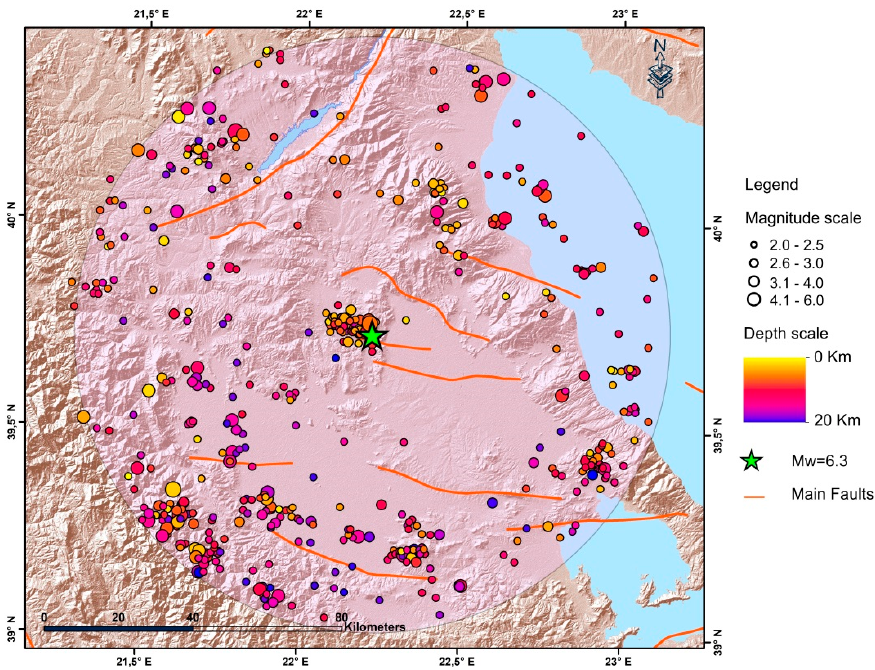
Figure 2. The observed seismicity in the Thessaly region between January 2016 and 3 March 2021, in an area of radius R = 80 km around the mainshock (star).